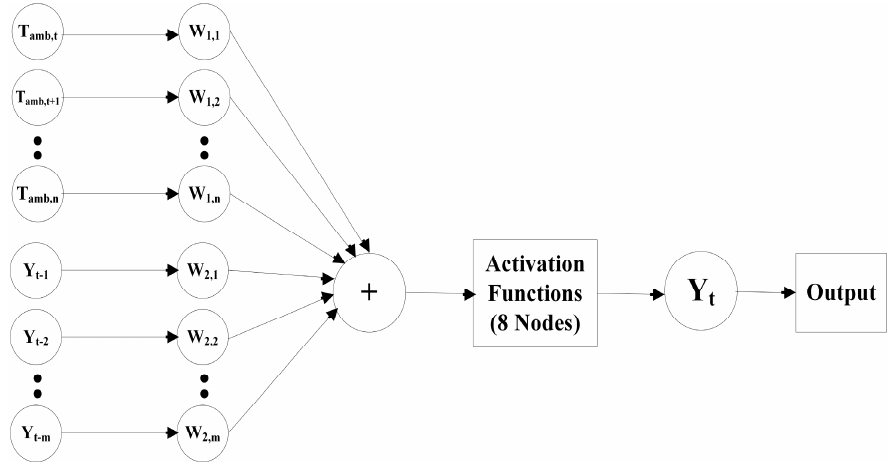
Figure 10. A diagram for base case N ‐ ARXnet structure for predicting energy demand.